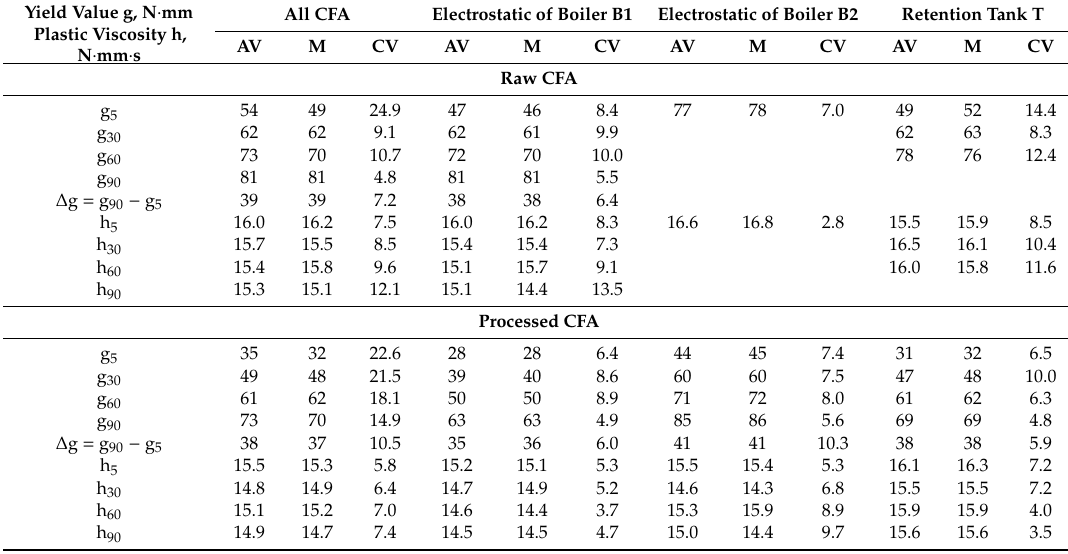
Table 7. Variability of rheological properties of CFA mortars. AV—average value, M—median, CV—coe ffi cient of variation,